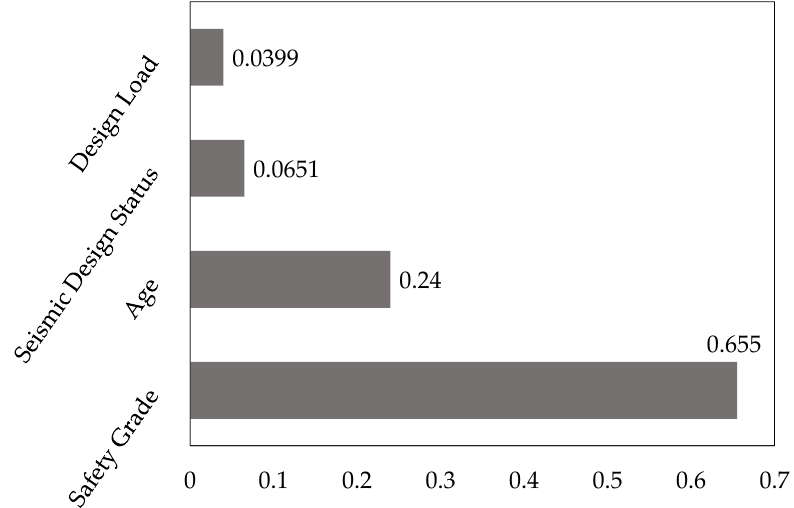
Figure 3. Factor ranking results following the analytical hierarchical process (AHP).